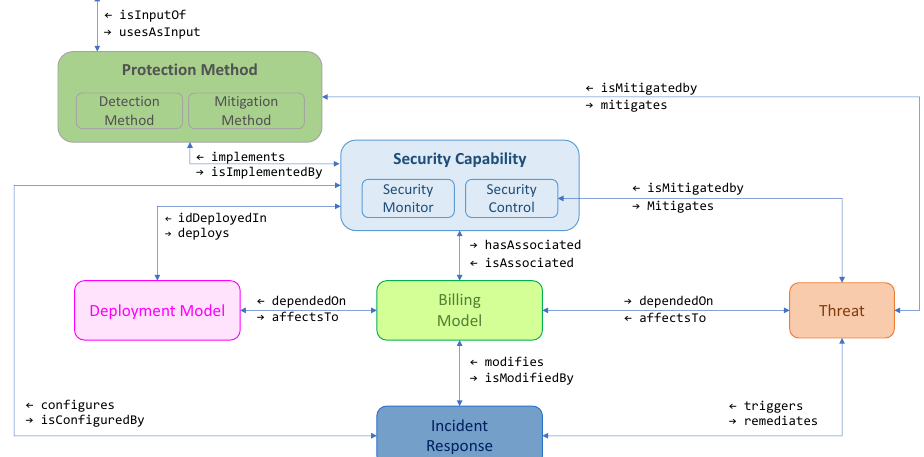
Figure 4. Ontology defined for the formalisation of data in the PALANTIR remediation